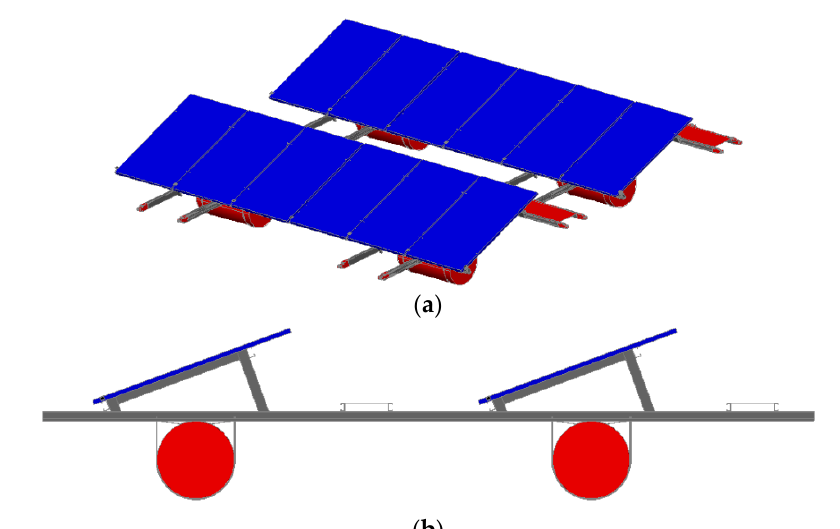
Figure 8. Separation distance.